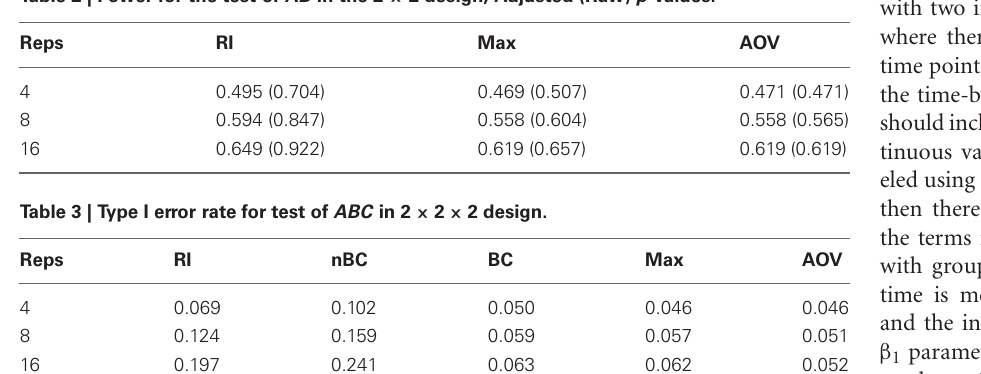
Table 2 | Power for the test of AB in the 2 × 2 design, Adjusted (Raw) p -values.